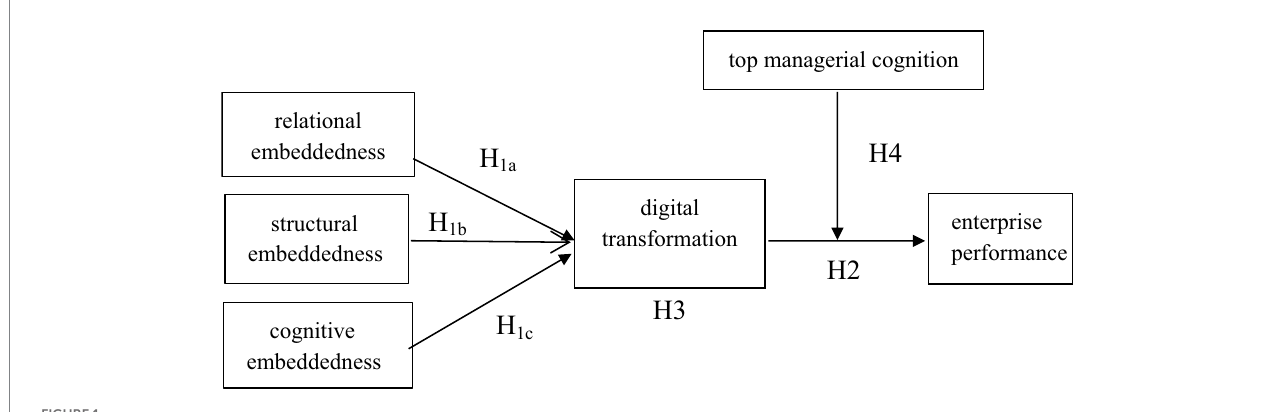
FIGURE 1 Mediator and moderating effect of the relationship between network embeddedness and enterprise